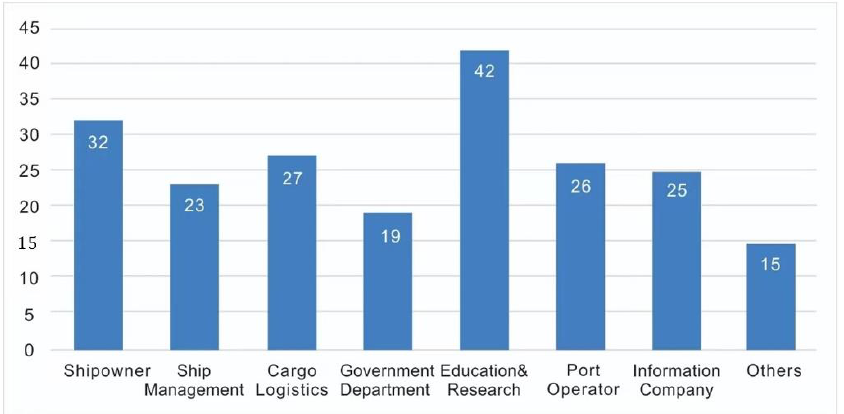
Figure 1. Distribution of stakeholders by business sector ( n = 209).